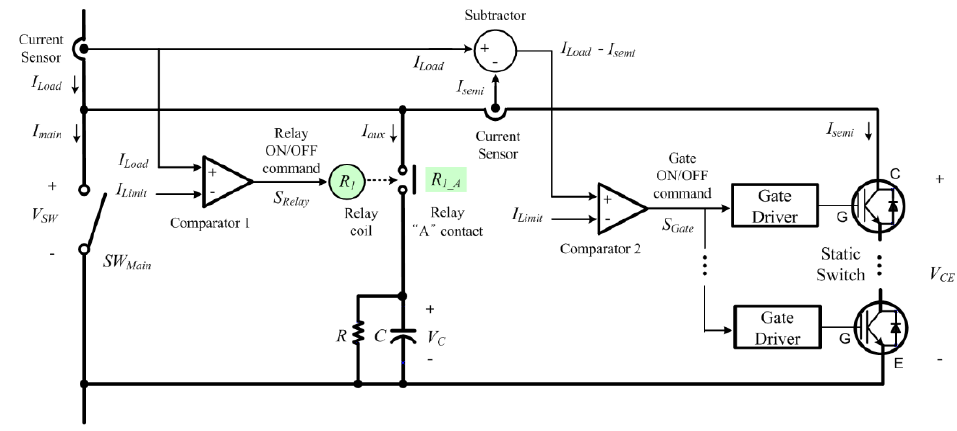
Figure 2. Sequence controller of the proposed MVDC hybrid circuit breaker.